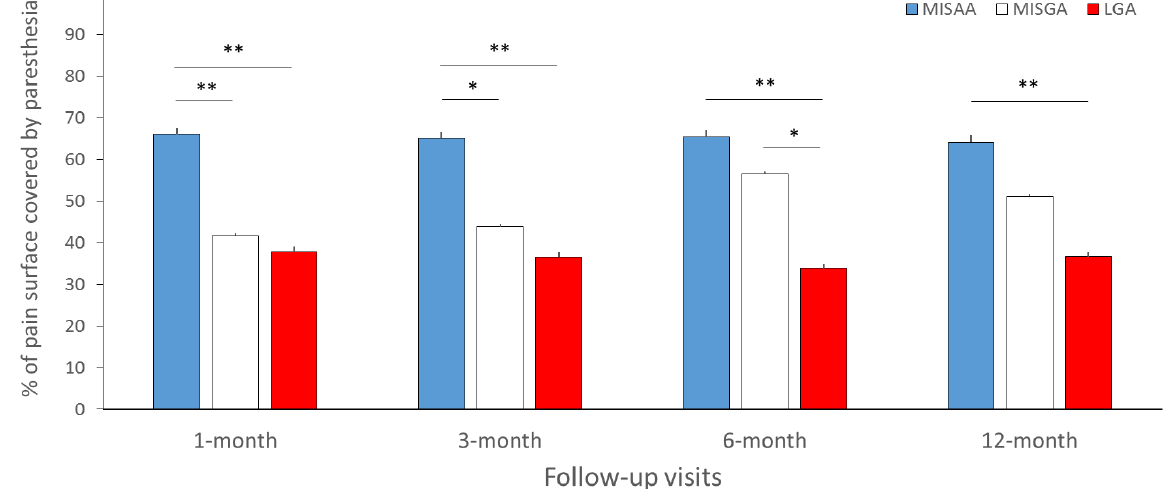
Figure 5. Mean paresthesia coverage (% of pain surface covered by paresthesia) for the MISAA (in blue), MISGA (in white) and LGA (in red) groups at the 1-, 3-, 6- and 12-month follow-up visits. MISAA: minimal invasive surgery under awake anesthesia; MISGA: minimal invasive surgery under general anesthesia; LGA: laminectomy under general anesthesia. * p < 0.05, ** p < 0.01, significant difference between groups.